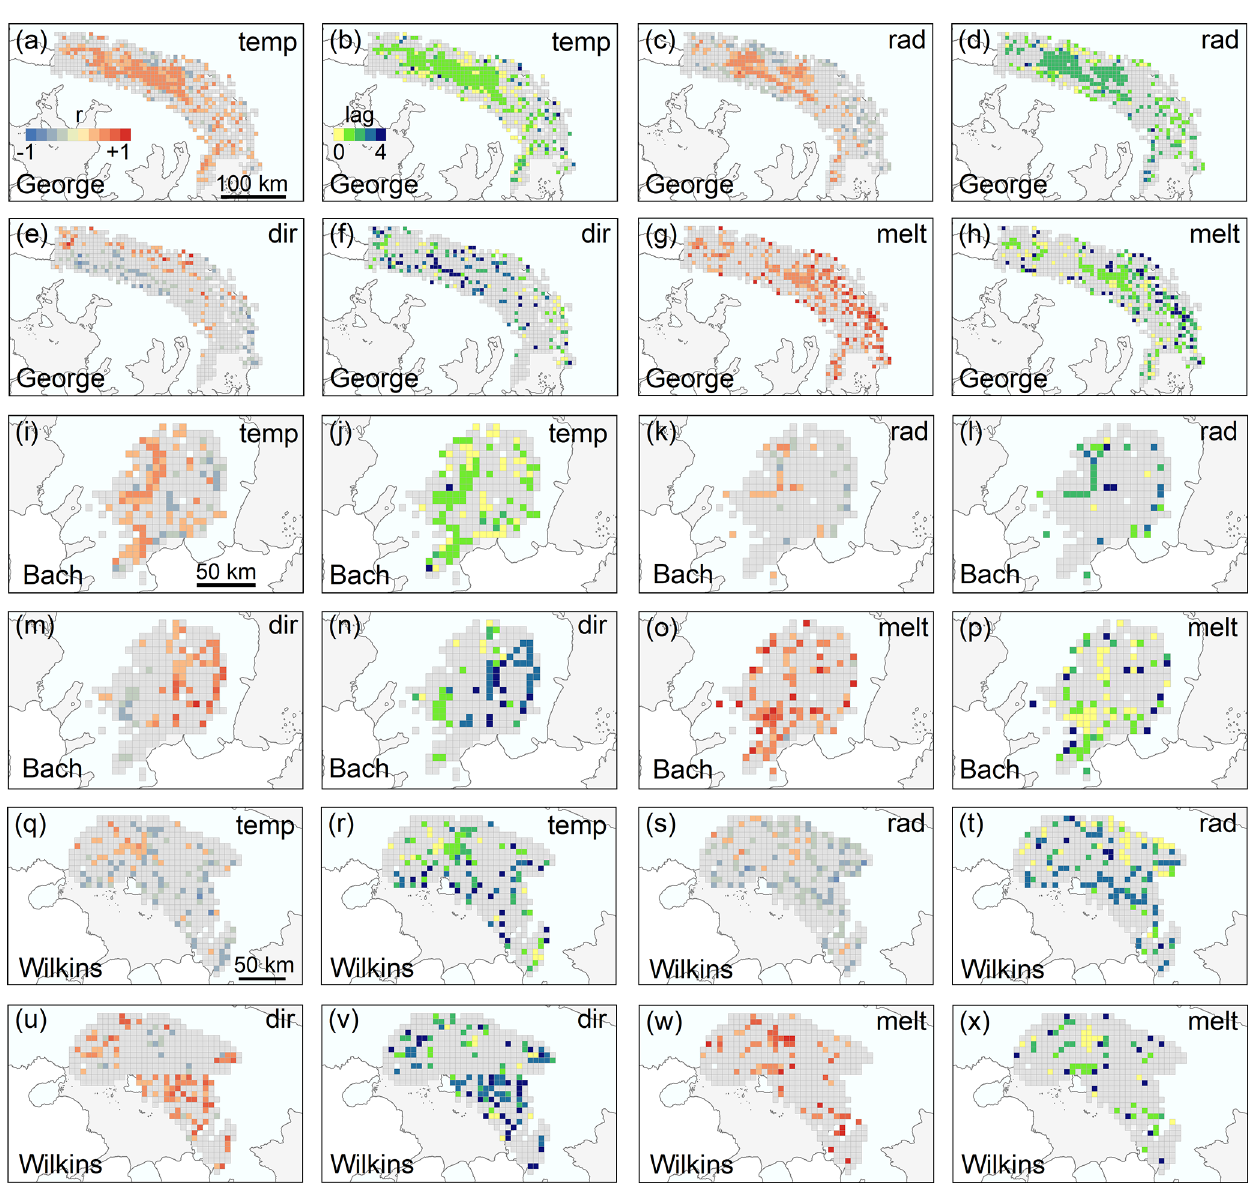
Figure 7. Pixel-based Pearson correlations ( r ) (a, c, e, g, i, k, m, o, q, s, u, w) and corresponding temporal lags (b, d, f, h, j, l, n, p, r, t, v, x) between fractional lake extents and climate variables air temperature (temp), solar radiation (rad), wind direction (dir) and snowmelt (melt) over the API ice shelves George VI (a–h) , Bach (i–p) and Wilkins (q–x) . Pixels with p > 0 . 05 are masked. The coastline and grounding line (grey) data are from Mouginot et al. (2017) and Rignot et al.